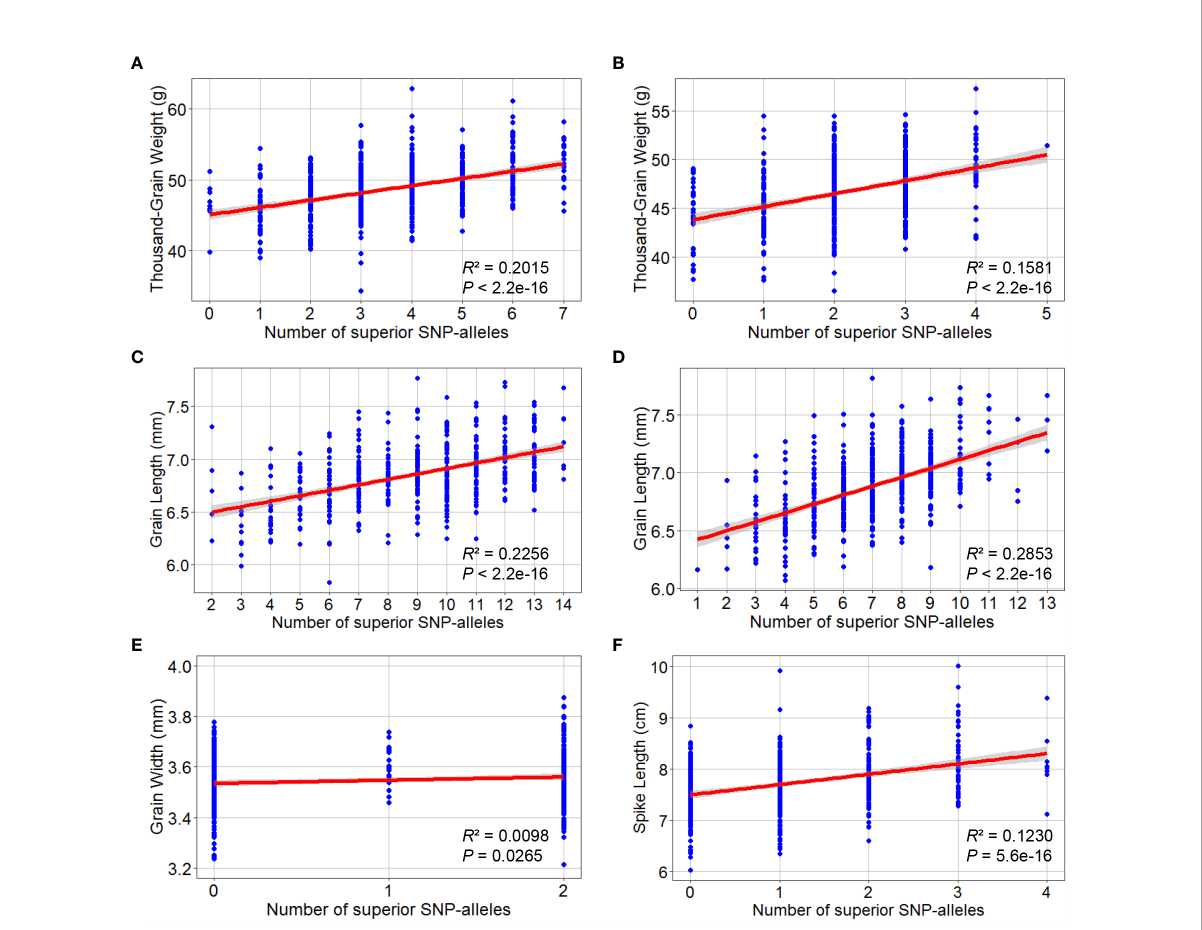
FIGURE 7 Superior allelic effects of the highest -log 10 ( P ) SNPs by GWAS for thousand-grain weight, grain length, grain width and spike length. Thousand- grain weight under normal (A) and drought treatment (B) conditions; Grain length under normal (C) and drought treatment (D) conditions; (E) Grain width under drought treatment condition; (F) Spike length under drought treatment condition. At the bottom of the box plot corresponding to each SNP